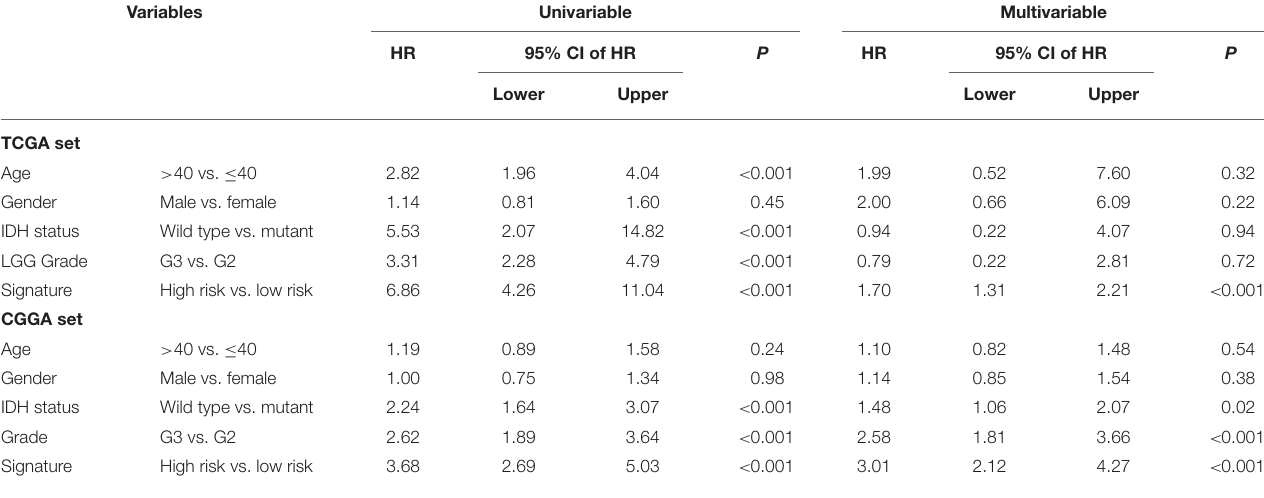
TABLE 2 | Univariable and multivariable Cox regression of the signature with patient survival in two LGG datasets.